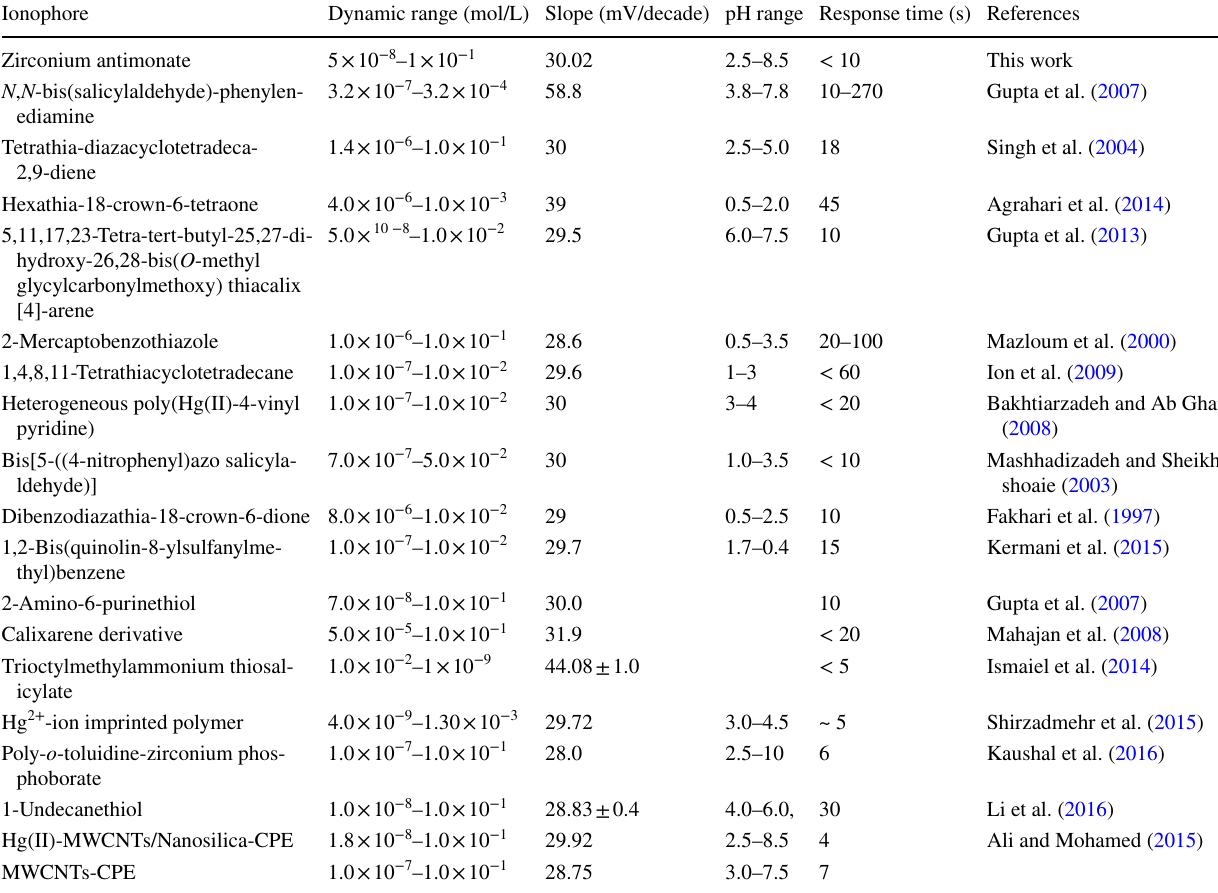
Table 5 Comparing some of the characteristics of Hg(II)-MSPE with some previously reported Hg(II)-ISEs